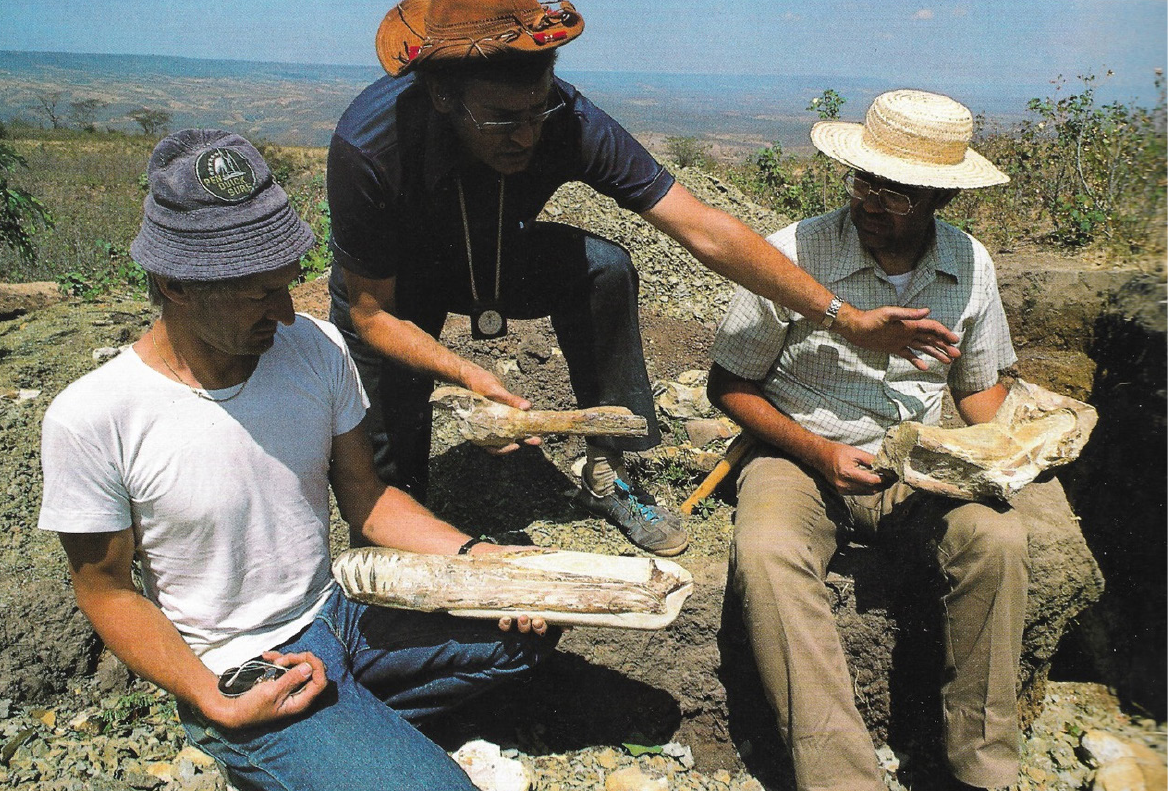
Figure 4. Giuseppe Leonardi, Philippe Taquet and Diogenes de Almeida Campos, on the field, looking after pterosaur skulls. September 1983. Araripe. North-East of Brazil. (photo